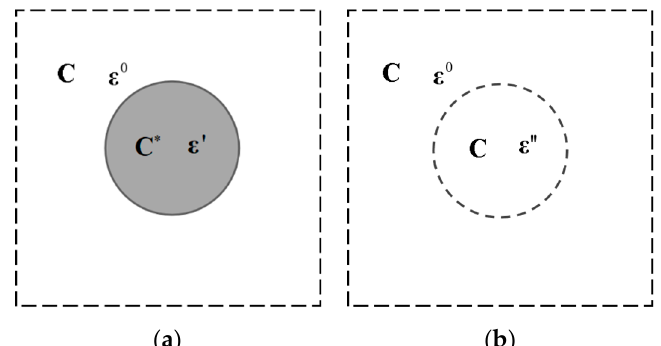
Figure 1. Equivalent transformation of ( a ) an inhomogeneous inclusion to ( b ) a homogeneous inclusion subjected to eigenstrain ε (cid:48)(cid:48)